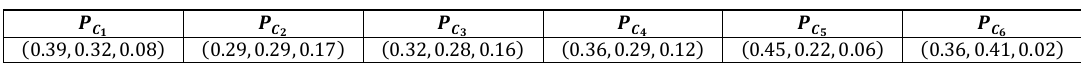
Table 13. The PFS of the criteria sets.